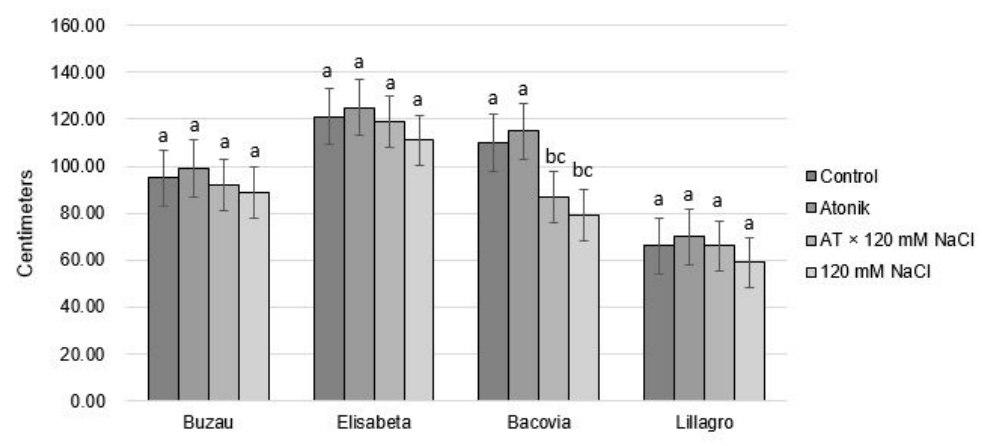
Figure 1. The effect of Atonik biostimulant on the height of tomato plants under saline stress after the first treatment. Different letters mean significant differences, according to the Tukey test. Error bars indicate ±SD.